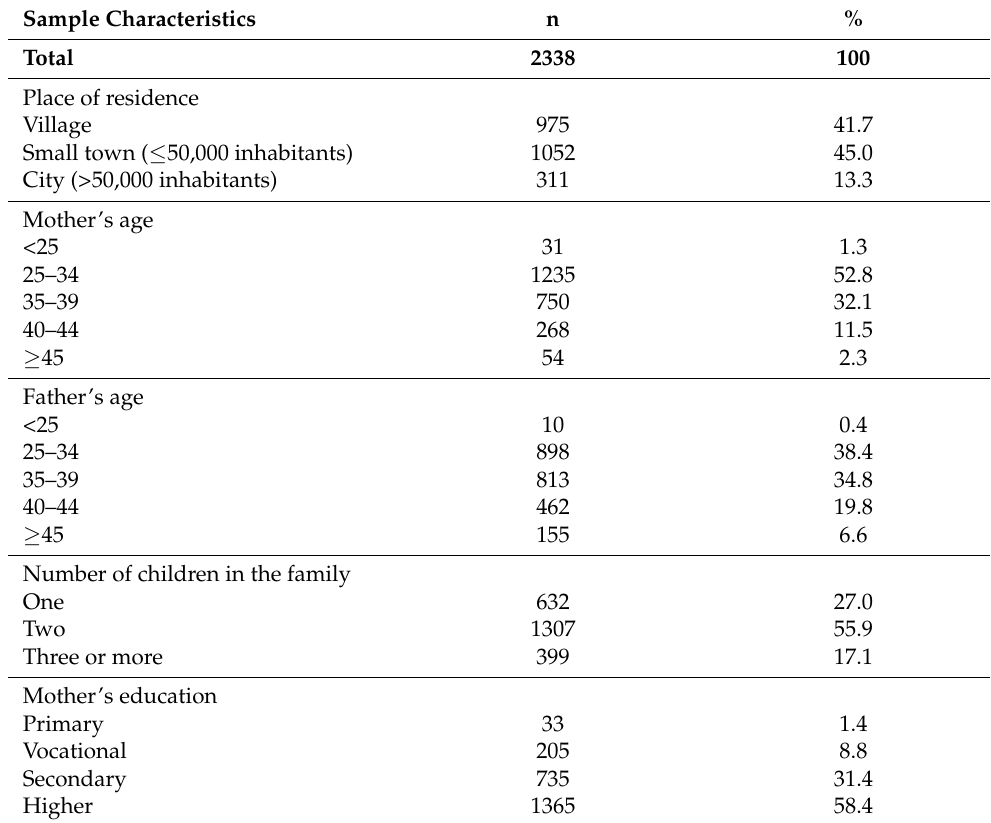
Table 1. Sociodemographic characteristics of study